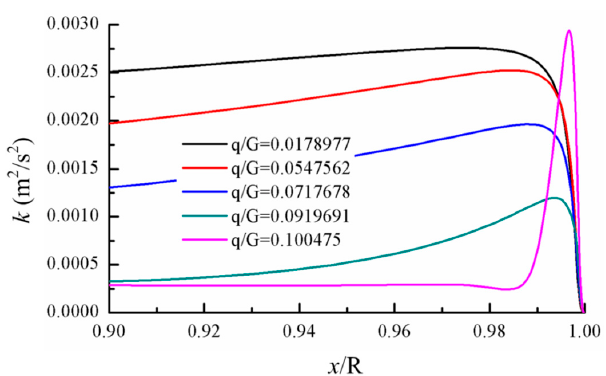
Figure 18. Distribution of the turbulent kinetic energy ( x/D = 26).